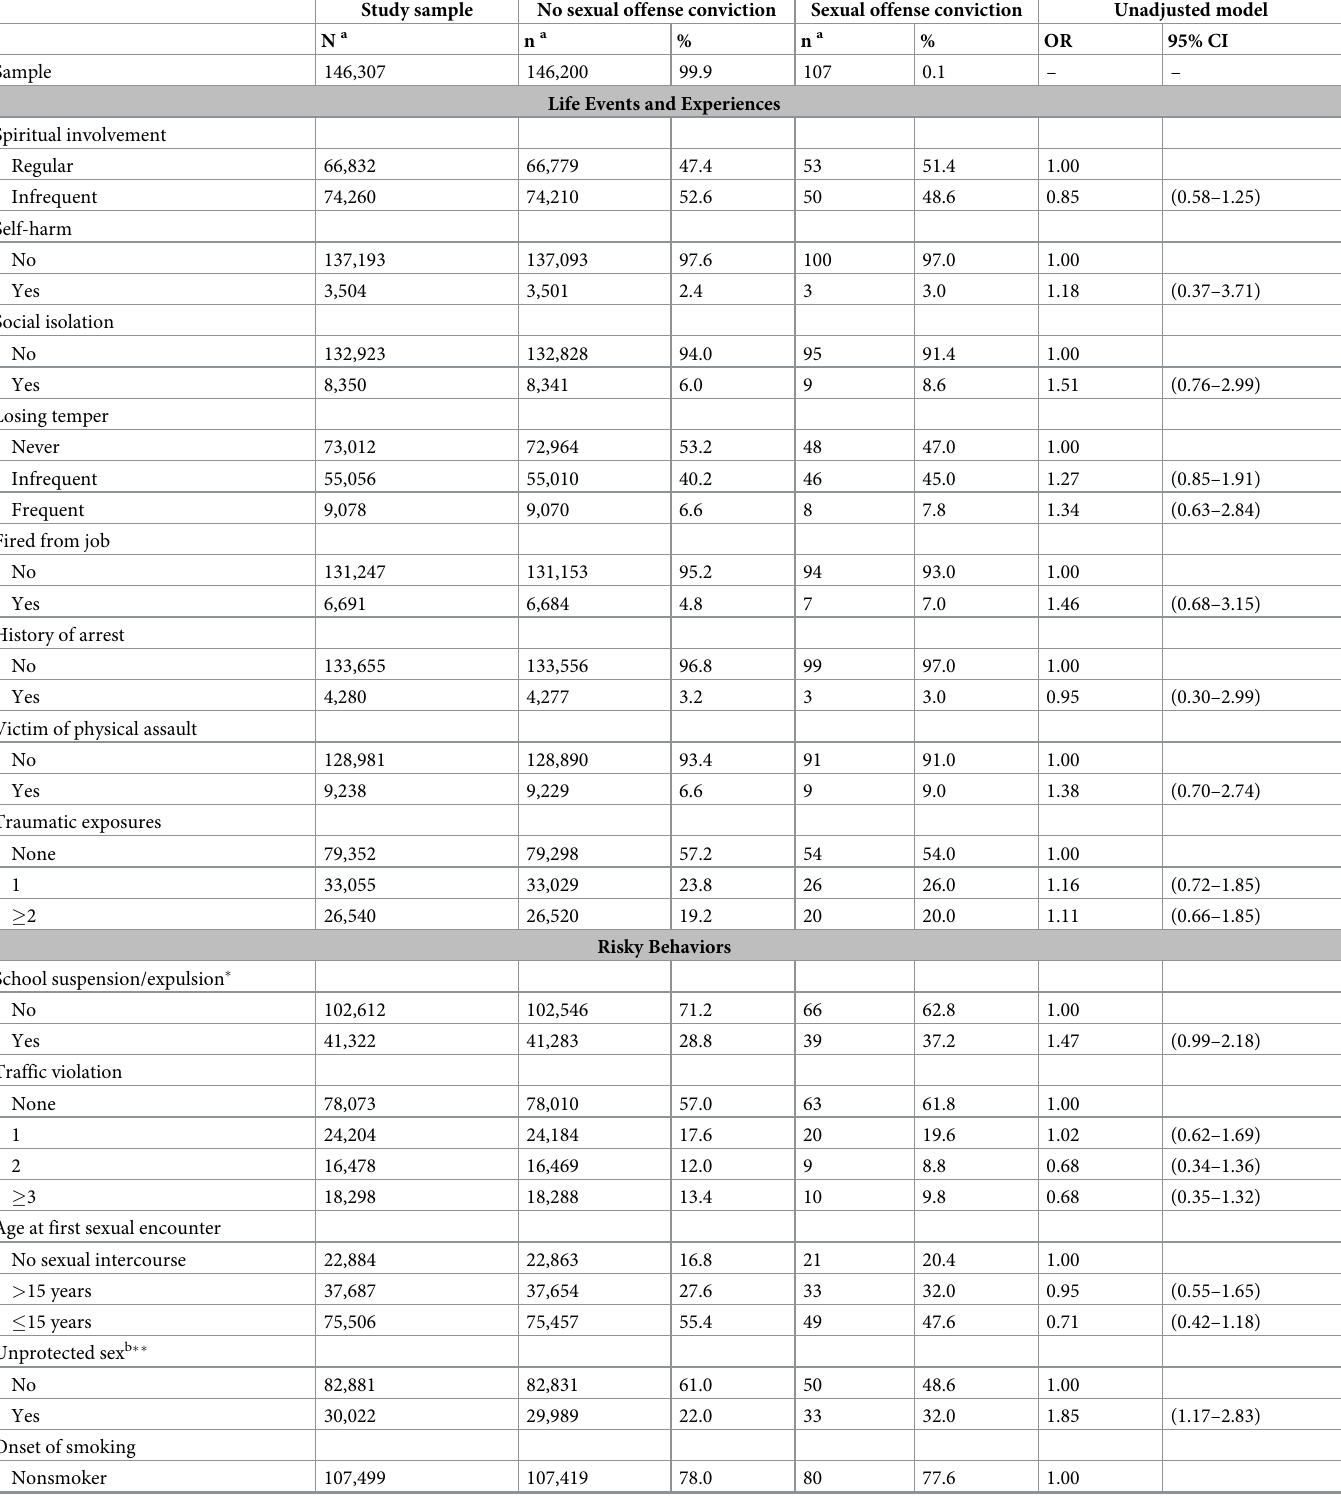
Table 2. Life events, experiences and risky behaviors by sexual offense conviction among U.S. male